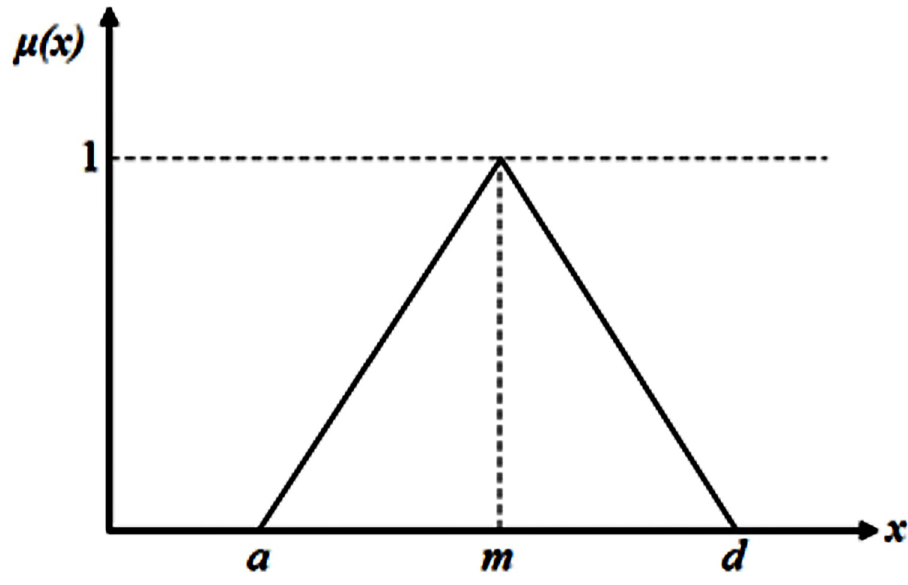
Fig 5. A triangular fuzzy number.